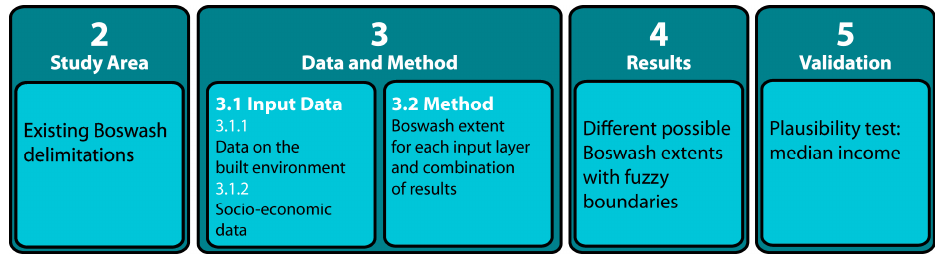
Figure 1. Structure of the paper.